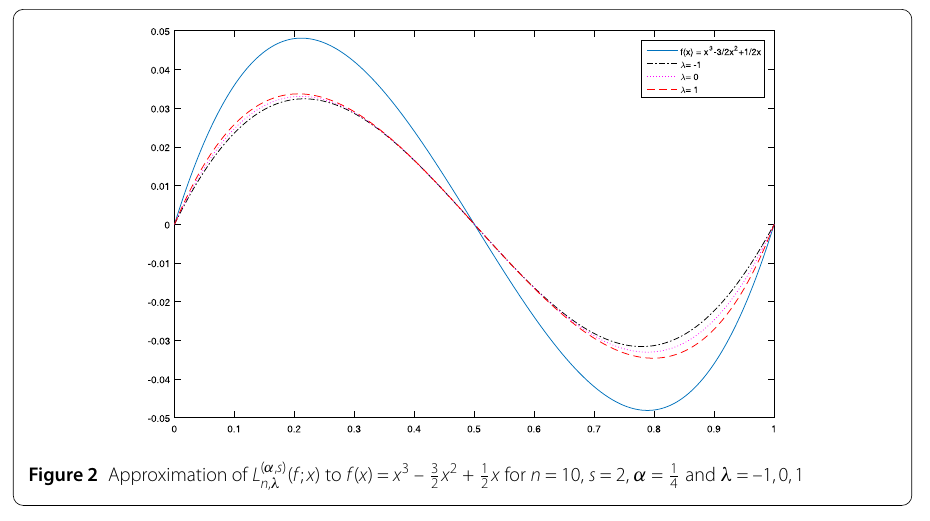
Figure 2 Approximation of L ( α , s )